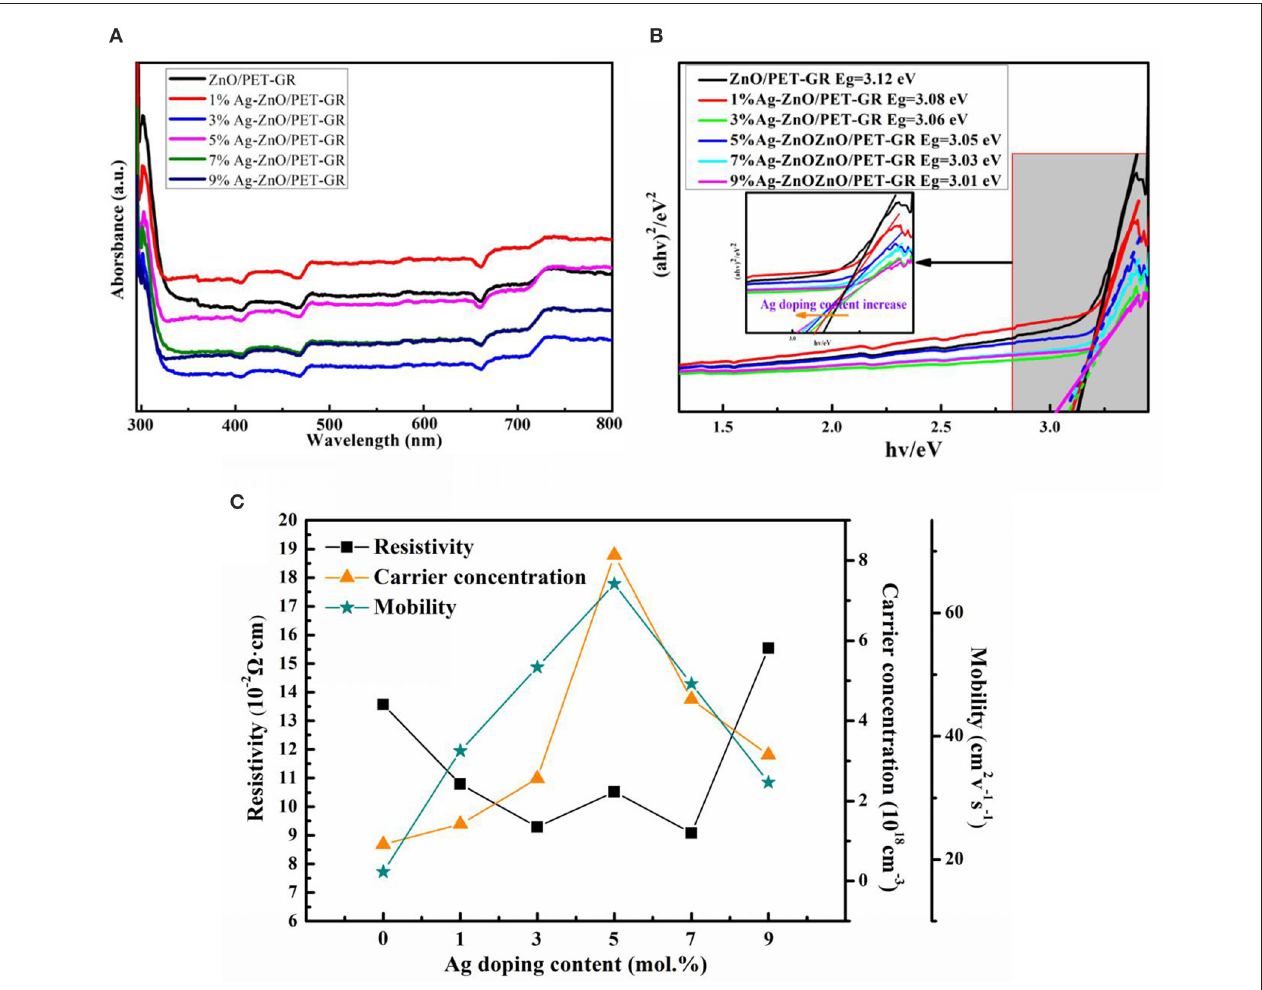
FIGURE 2 | (A) UV-vis absorption spectra of ZnO thin films with different silver nitrate doping concentrations and (B) the ( α h ν ) 2 ∝ h ν relationship diagram; (C) electrical properties of the Ag-ZnO/PET-GR composite structure.